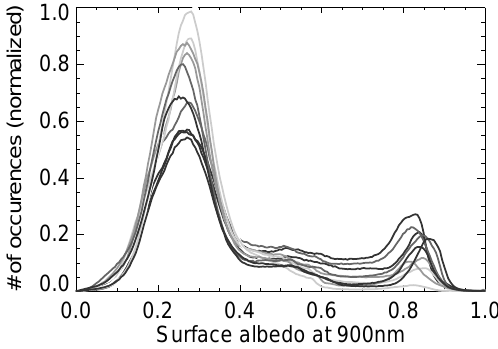
Fig. 4. Global, normalized histograms of surface albedo at 900nm through the year 2004 (grey shading indicating seasonal depen- dence with dark grey indicating winter and light grey indicat- ing summer months). The data was extracted from the MERIS Albedomap data set (Muller et al.,